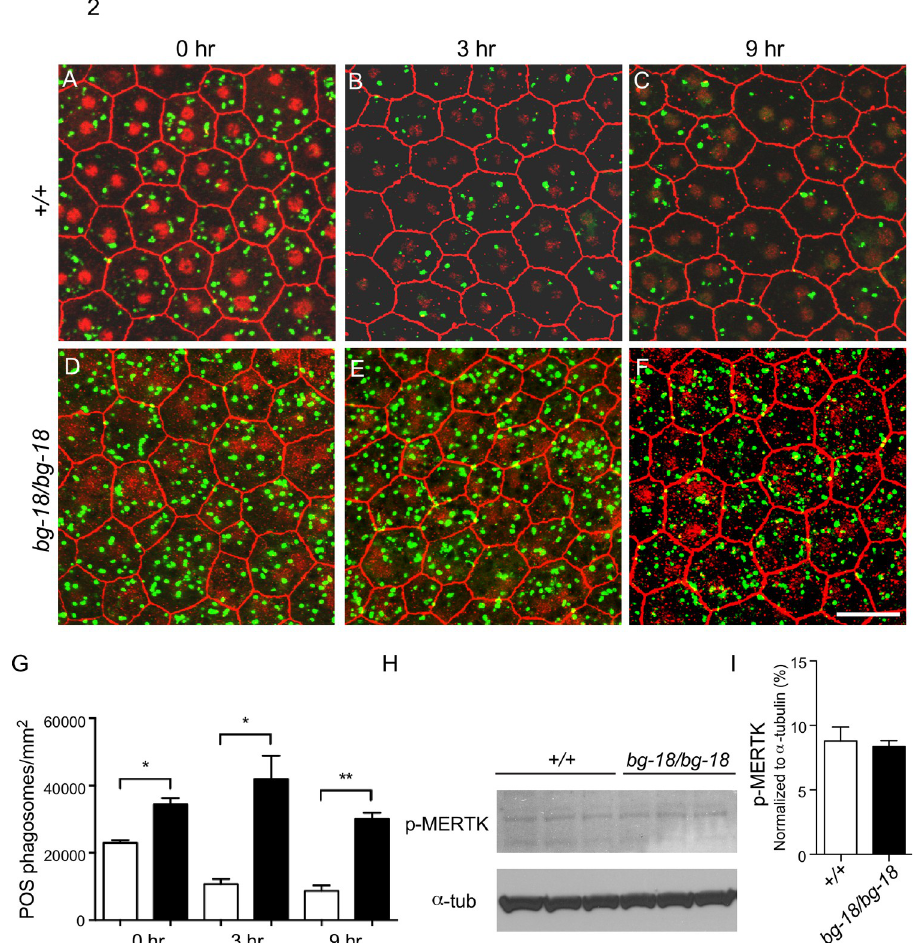
Fig 2. Accumulation of phagosomes in bg-18 RPE cells. (A-G) Number of phagosomes in RPE from 7 to 8-week-old wild-type and bg-18 mutant mice. Wild type (A-C) and bg-18 mutant (D-F) RPE was incubated with antibodies against ZO-1 (red) and rhodopsin (green), after dissection at 0 (A, D), 3 (B, E), and 9 (C, F) hours after the onset of light at 6 AM. Note that the ZO-1 staining in the nuclei is an artifact of over-staining with DAPI which can result in bleed over signal into the red channel. This does not affect the green channel. Scale bar = 50 μ m. Images covering larger areas are shown in S6 Fig. The results were quantified and analyzed using unpaired t -test (G). � : P < 0.05, �� : P < 0.01, mean ± SD, n = 3. (H-I) Ingestion of POS tips is not affected in the bg-18 mutant RPE from 5-week-old mice, as assessed by the phospho-MERTK level using western blot analysis (H). Quantified results are shown in (I) as mean ± SD, n = 3 per